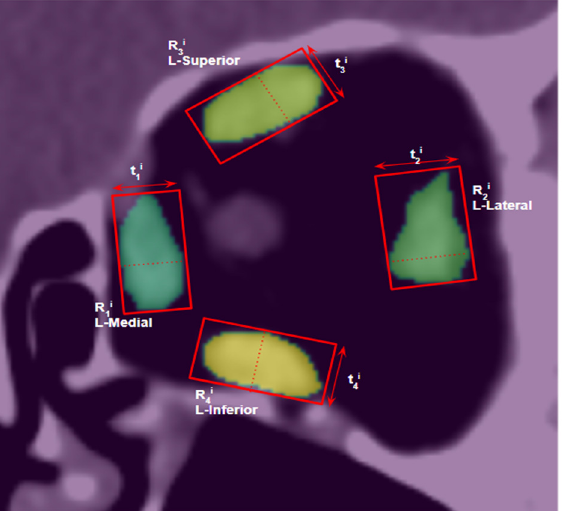
Figure 5. Illustration of thickness measurements ( t 1i , t 2i , t 3i , t 4i ) on a coronal slice i , using rotated rectangles of the minimum area ( R 1i , R 2i , R 3i , R 4i ) enclosing the segmented muscle contours (L-medial, L-lateral, L-superior, L-inferior), respectively.